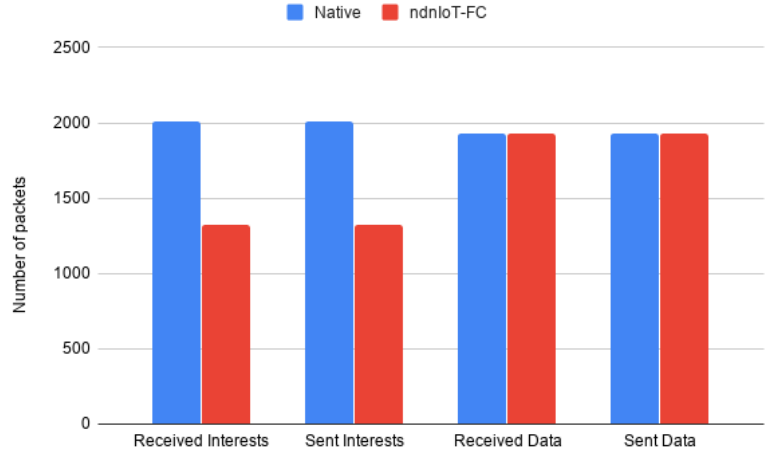
Figure 12. Use case 2—Network overhead